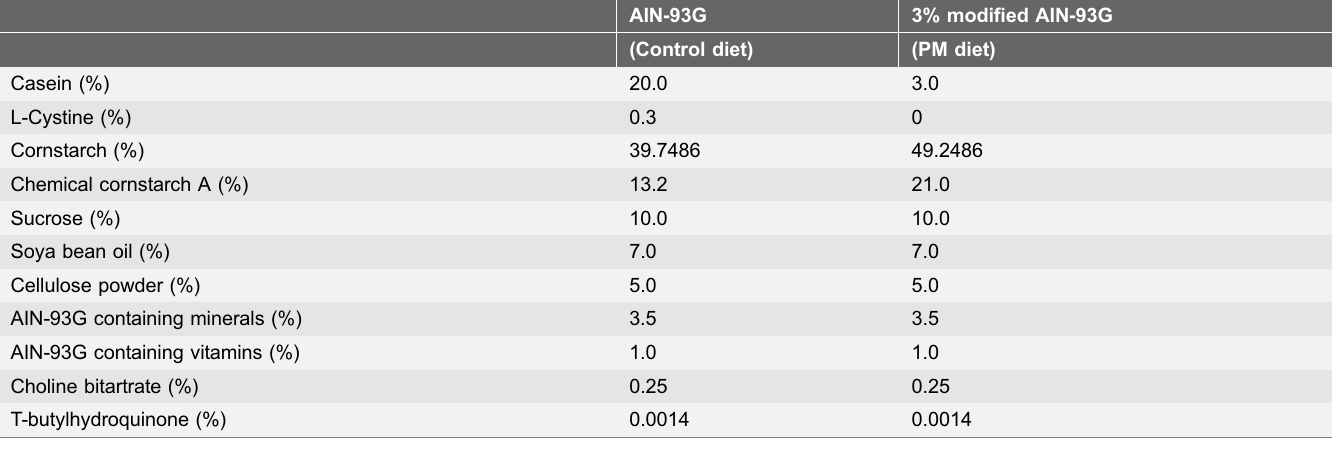
Table 2. The ingredients of the AIN-93G and 3% modified AIN-93G rodent